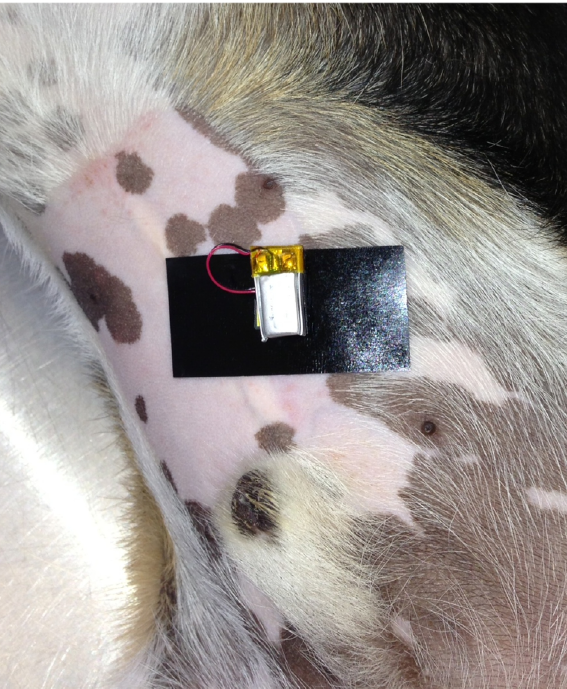
Figure 1. The miniaturized device is placed on a clipped area on the ventral abdomen of a beagle dog and attached using a sticky